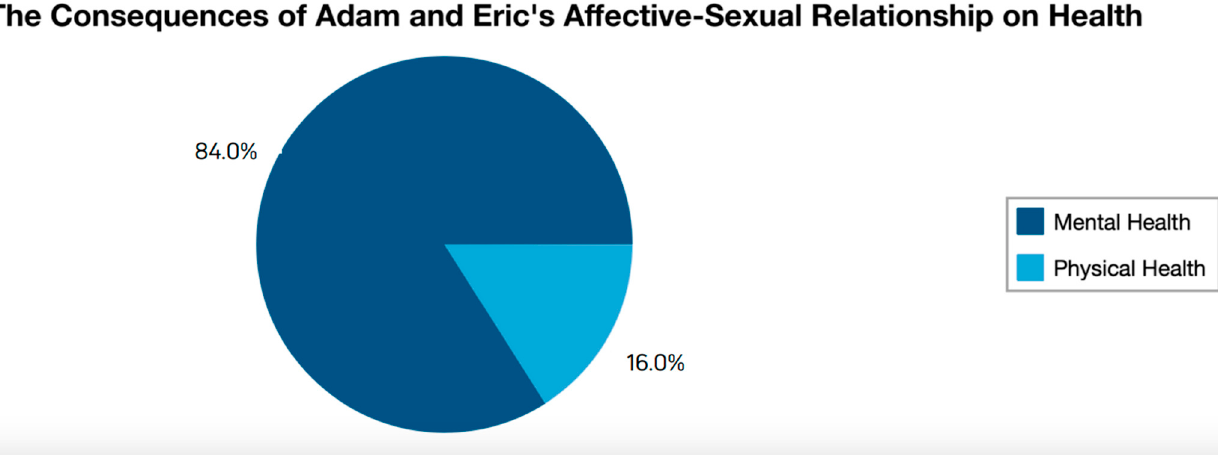
Figure 3. Main results on the negative health consequences of Adam and Eric’s affective-sexual re-